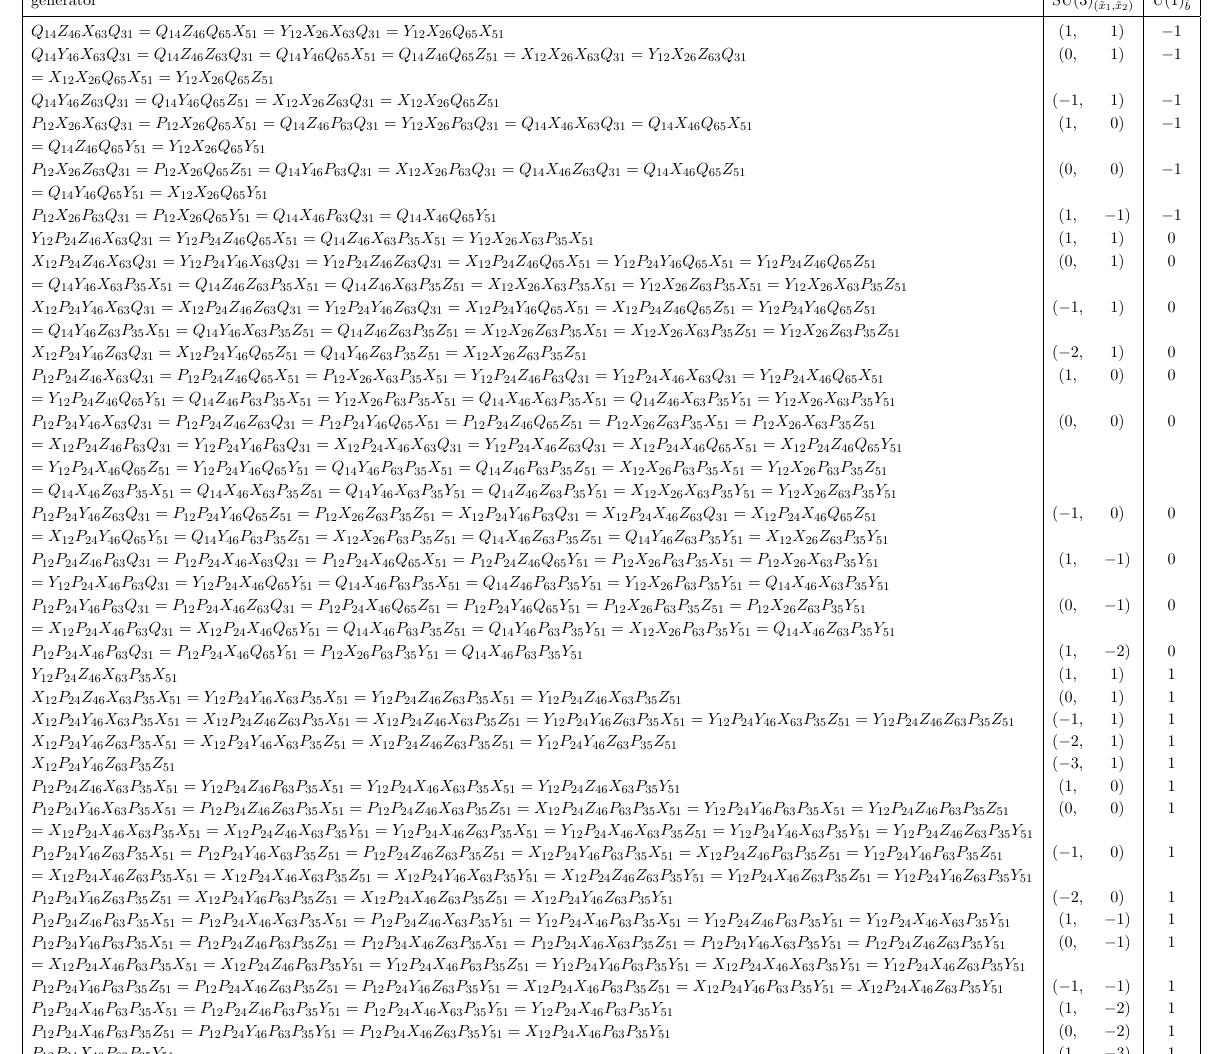
Table 14 . The generators in terms of bifundamental chiral fields for Model 3.